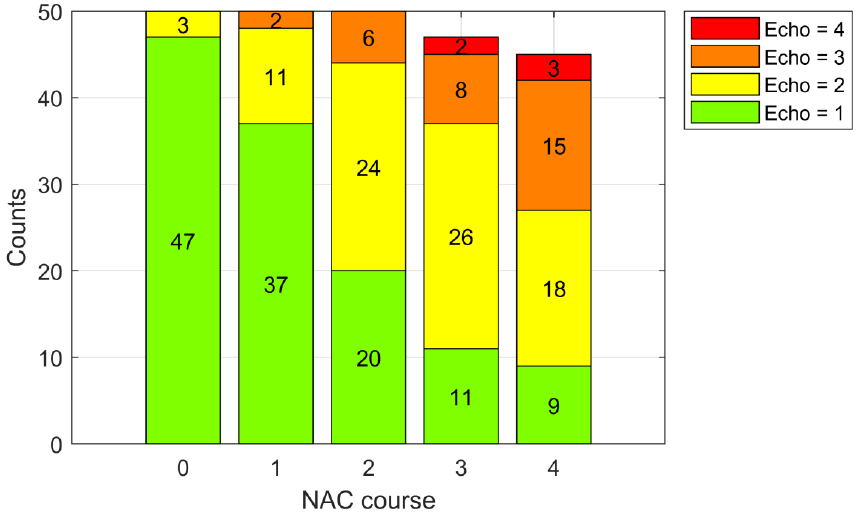
Figure 3. Echogenicity distribution of tumors before treatment (0) and after subsequent chemo- therapy courses.